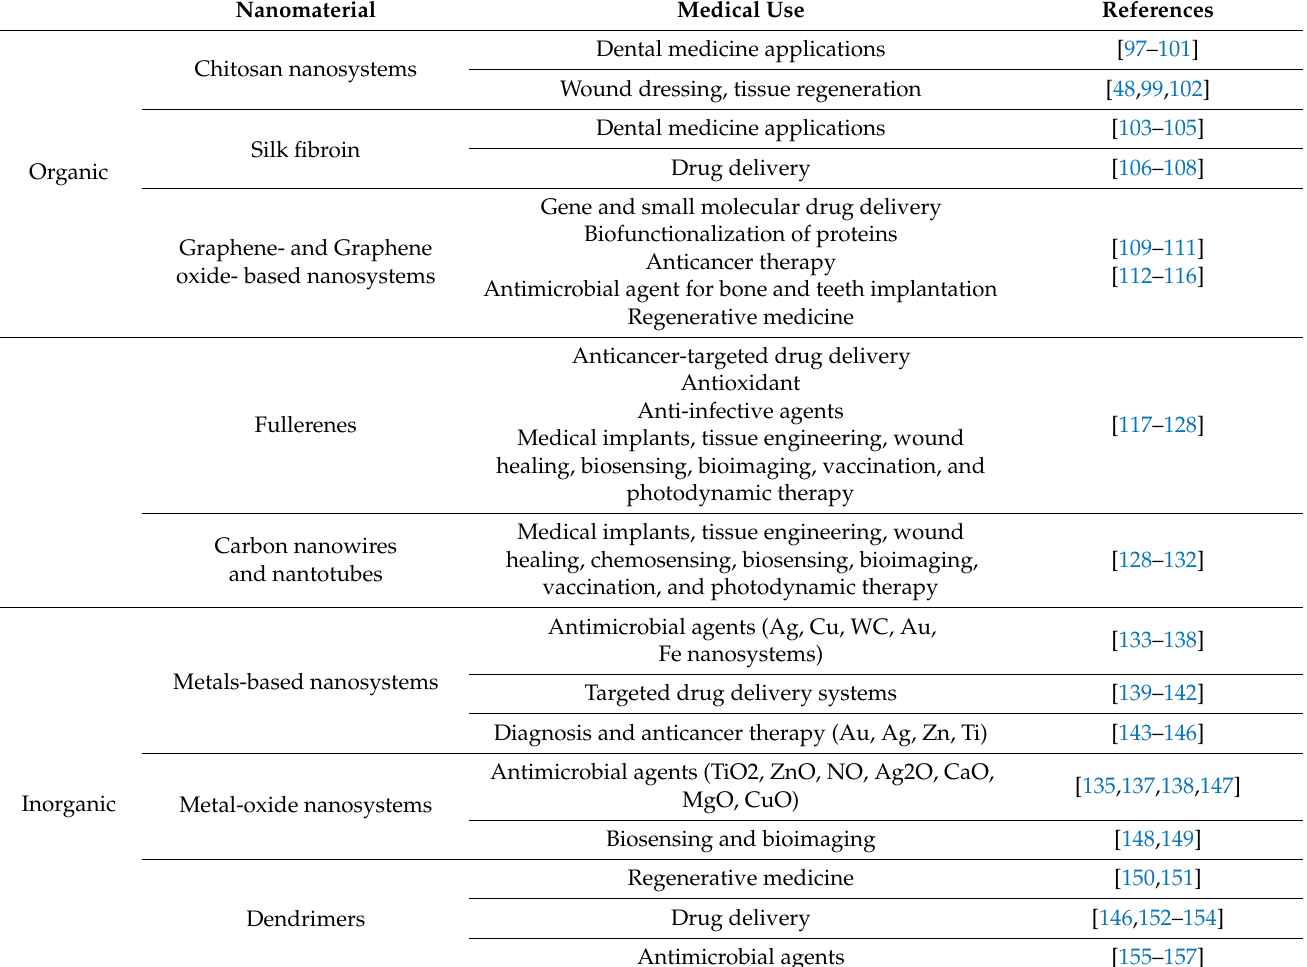
Table 3. Summary of the discussed nanomaterial with their formulation, nature, composition, and their reported medical